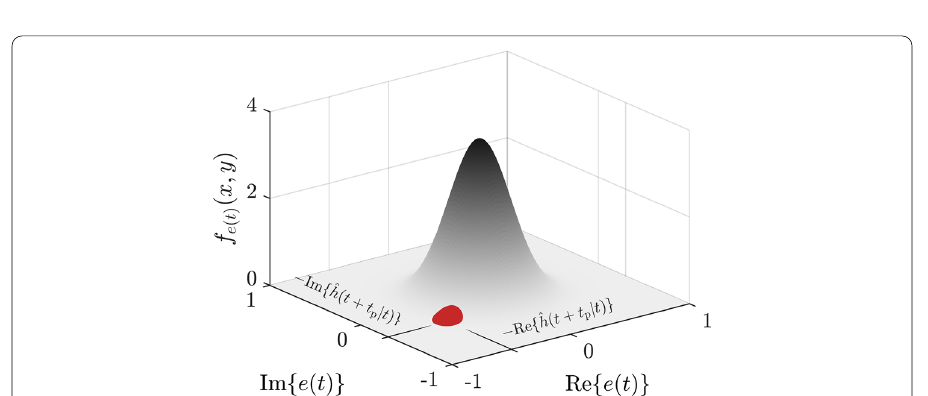
Fig. 6 Illustration of the integration area to calculate the future outage probability. The red circle marks the integration area and has radius | h min